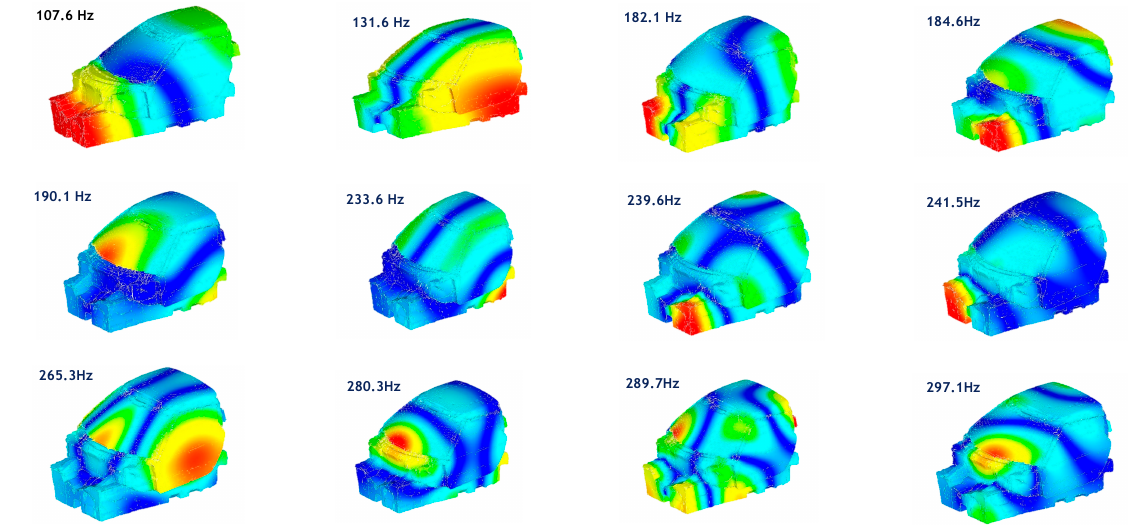
Figure 23. Cavity modes of passenger compartment.